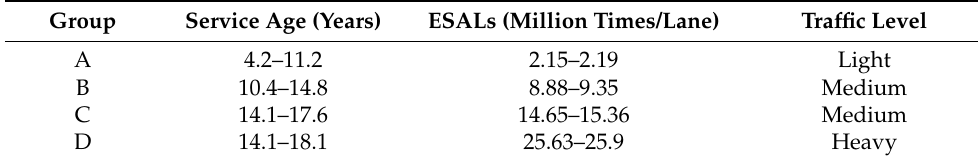
Table 3. Information about the four sample